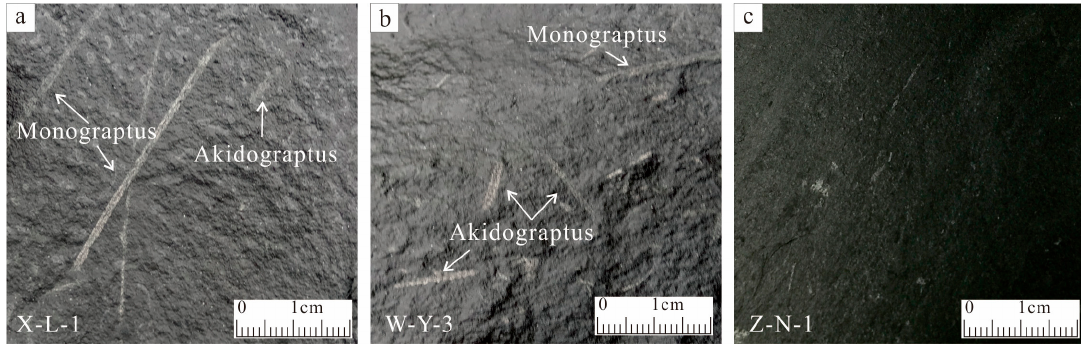
Figure 3. The lithological characteristics of the collected samples: ( a ) graptolites in LSL shale; ( b ) graptolites in UOW shale; ( c ) pure LCN shale.